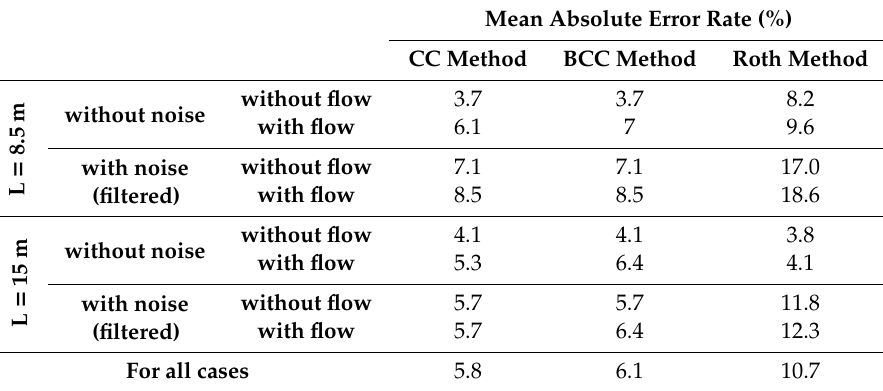
Table 8. Mean absolute error rates for the three studied